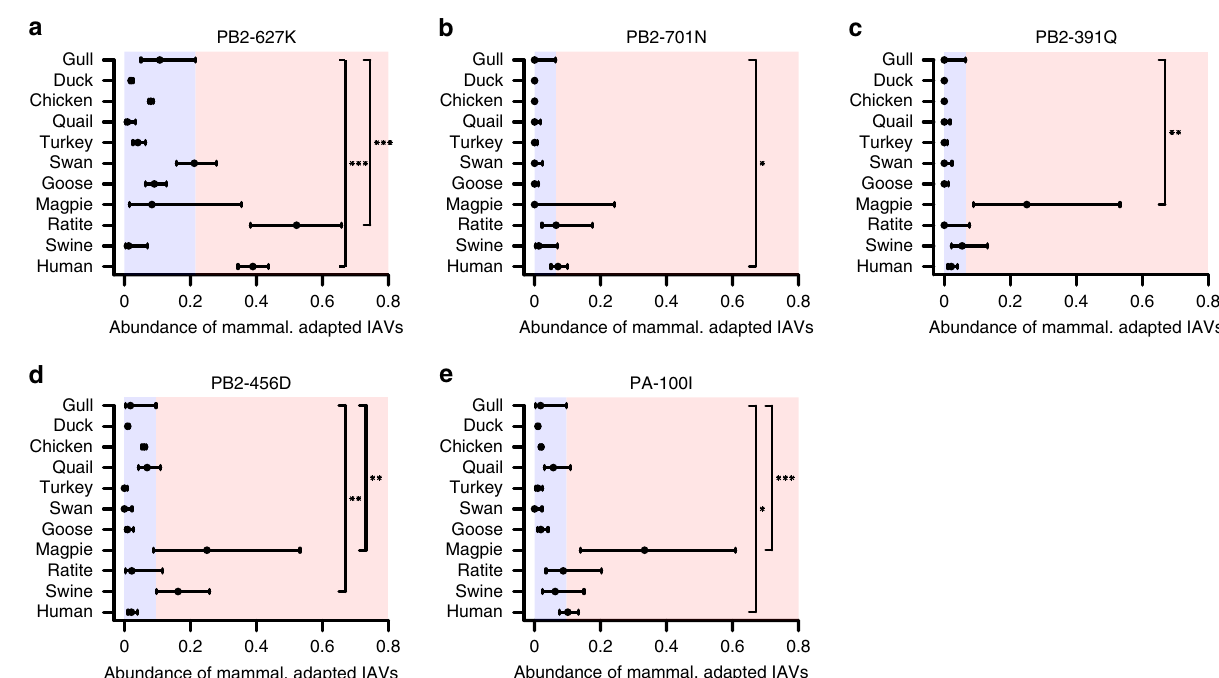
Fig. 7 Analysis of surveillance data suggests enrichment of mammalian-adaptive vPol substitutions in IAVs isolated from magpies. a – e Abundance of mammalian-adaptive vPol sequences in H5, H7, and H9 IAVs isolated from the indicated species: a PB2-627K; b PB2-701N; c PB2-391Q; d PB2-456D; and e PA-100I. Error bars indicate 95% con fi dence intervals of the abundance of the speci fi c substitution in the species population. Blue shading broadly highlights the range expected in species expressing only ANP32A_X1, thus indicating substitution abundances typically found in species selecting for avian- like vPol variants, while red shading broadly highlights the substitution abundance expected in species selecting for mammalian-like vPol variants. Stars indicate that the identi fi ed mammalian-like vPol substitutions are signi fi cantly higher in abundance than those found in species expressing only ANP32A_X1 (i.e. gull). Signi fi cance was determined by a one-sided proportion test (*0.01 < p < 0.05; **0.001 < p < 0.01; *** p < 0.001). All other comparisons were non-signi fi cant. Source data, including sample sizes, for all panels are provided in the Source Data fi and their consequences for cross-species transmission and human pandemic emergence.